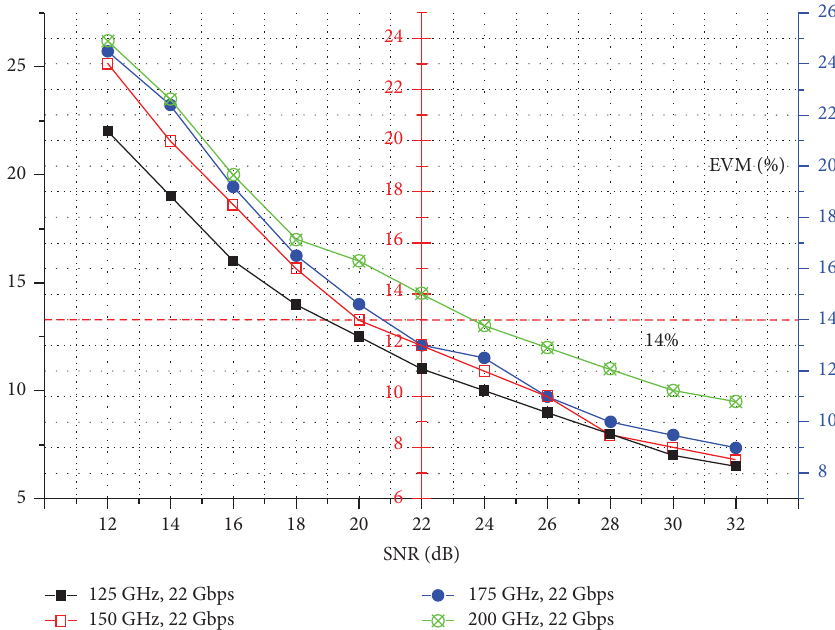
Figure 5: Various sub-THz signals measurements for evaluating integrated fber-FSO efciency.